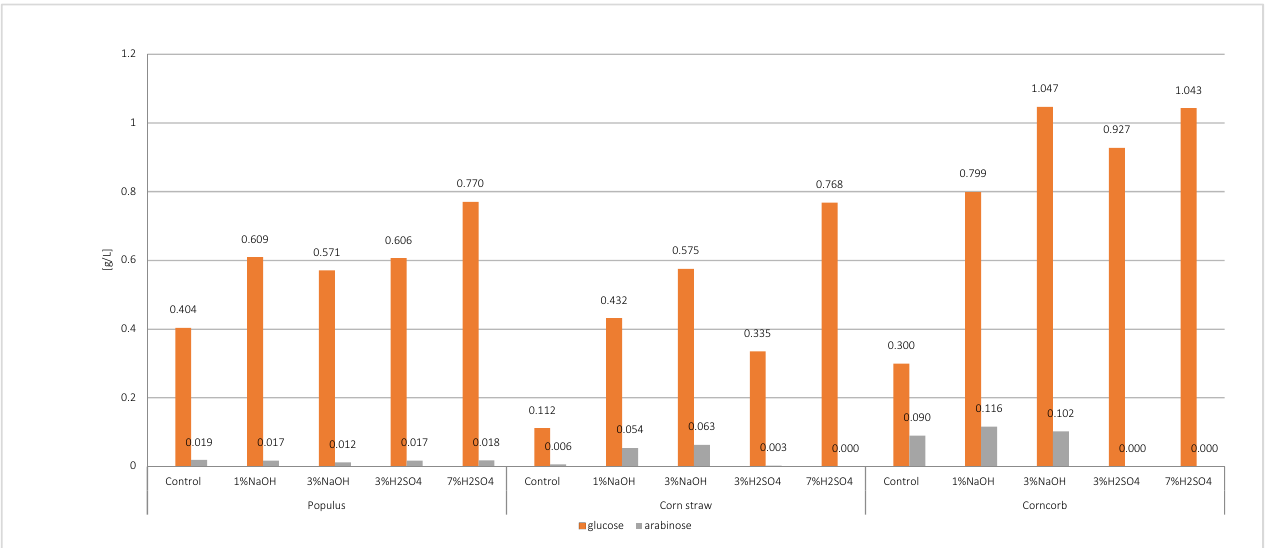
Figure 1. Contents (g/L) of glucose and arabinose in Populus L. and corn waste before and after pretreatment.